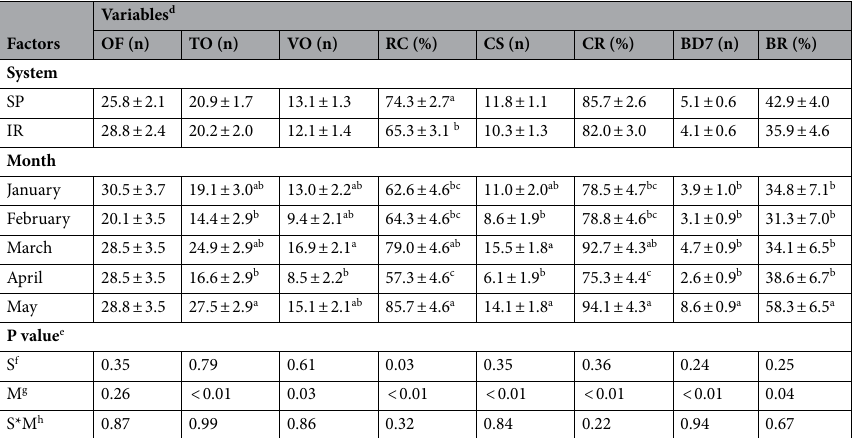
Table 3. Least square means ± standard error of ovum pick-up-related variables and in vitro embryo production from primiparous Canchim cows kept in silvopastoral (SP) or intensive rotational grazing systems (IR). a,b,c = means followed by different lowercase letters on the same column are significant. d OF observed follicles, TO total oocytes, VO viable oocytes, RC recovery rate of oocytes, CS number of structures cleaved, CR cleavage rate, BD7 number of blastocysts in D7, BR blastocyst rate in D7, e P values < 0.05 were considered significant, f S system, g M month (experimental month), h S*M interaction between system and